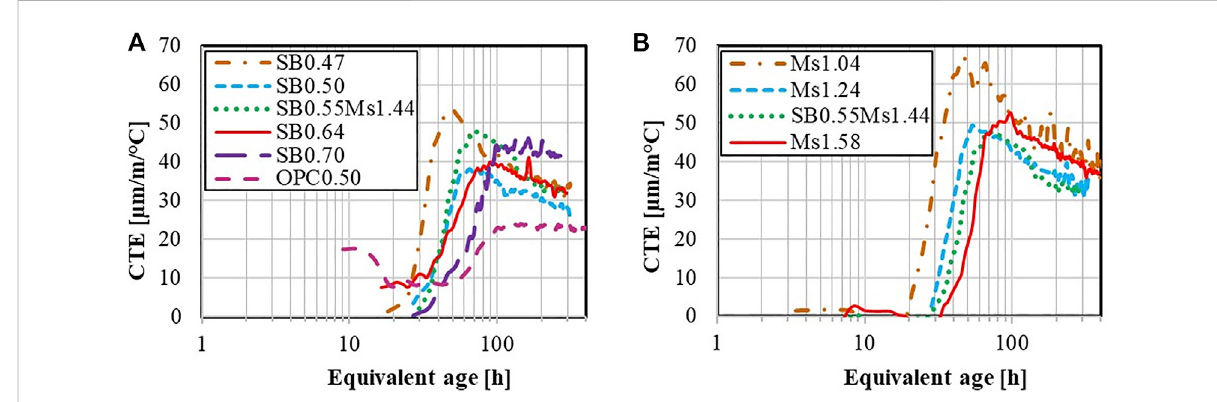
FIGURE 7 Coef fi cient of thermal expansion of AASF pastes as a function of the equivalent age with different S/B (A) and with different M s (B) .